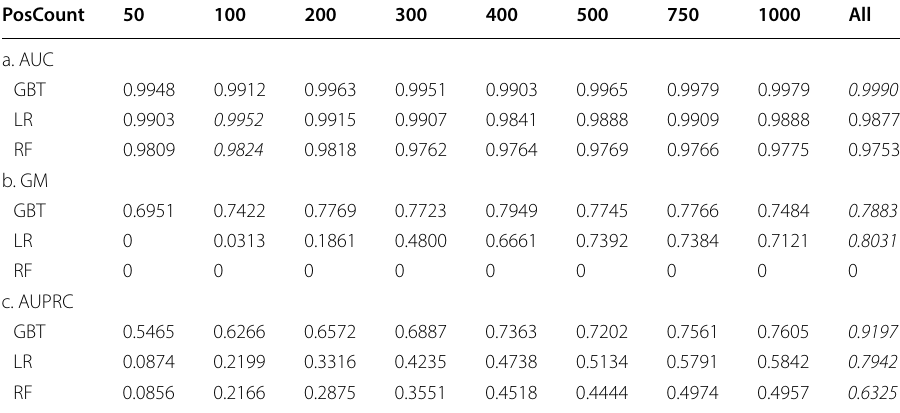
Table 4 POSTSlowloris Combined average